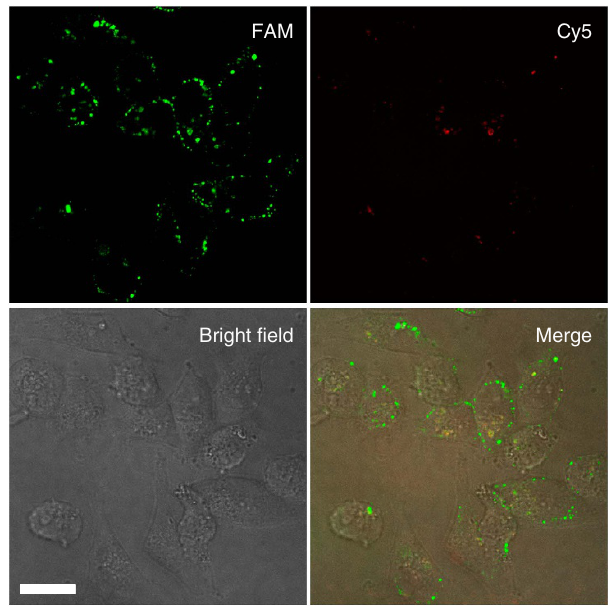
Figure 7 | Images of MDA-MB-231 cancer cells from the fluorescence